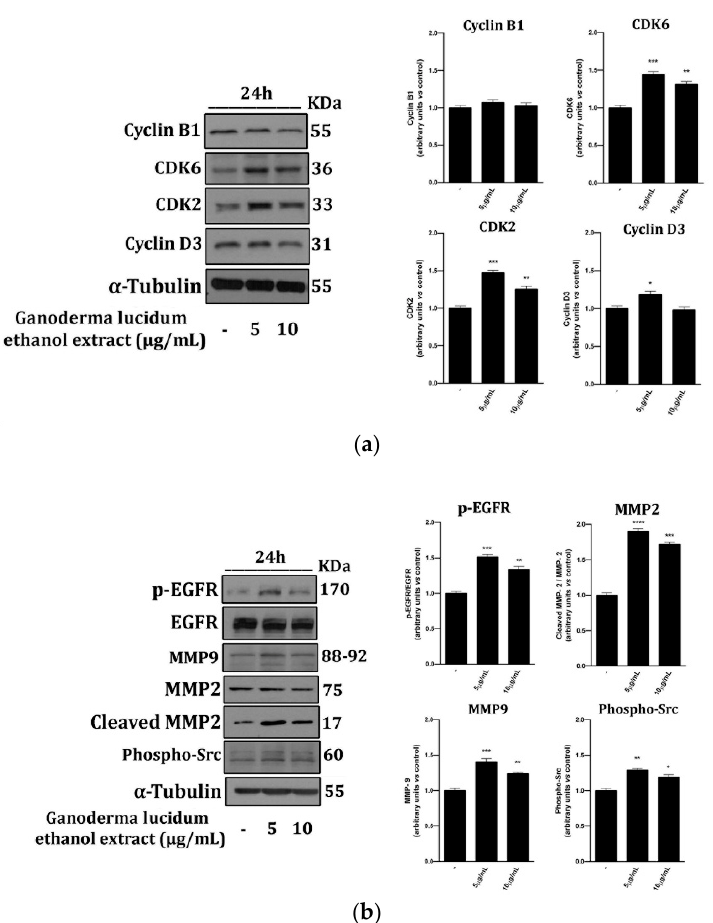
Figure 4. G. lucidum ethanol extracts induced cell cycle progression and migration protein expression. ( a ) Western blot analysis of cyclin B1, CDK6, CDK2 and cyclin D3 in whole cell extracts from HaCaT cells cultured for 24 h in the presence of the indicated concentrations of G. lucidum ethanol extract: Tubulin was used as a control for protein loading. The panel shows a representative Western blot of three di ff erent experiments performed with similar results. Histograms represent mean ± SD in densitometry units of scanned immunoblots from the 3 di ff erent experiments (ANOVA, *** p < 0.001, ** p < 0.01 and * p < 0.05). ( b ) Western blot analysis of p-EGFR (epidermal growth factor receptor) , EGFR, MMP-2 (total and cleaved), MMP-9 and Phospho-Src in whole cell extracts from HaCaT cells cultured for 24 h in the presence of the indicated concentrations of G. lucidum ethanol extract: Tubulin was used as a control for protein loading. The panel shows a representative Western blot of three di ff erent experiments performed with similar results. Histograms represent mean ± SD in densitometry units of scanned immunoblots from the 3 di ff erent experiments (ANOVA, **** p < 0.0001, *** p < 0.001, ** p < 0.01 and * p < 0.05).